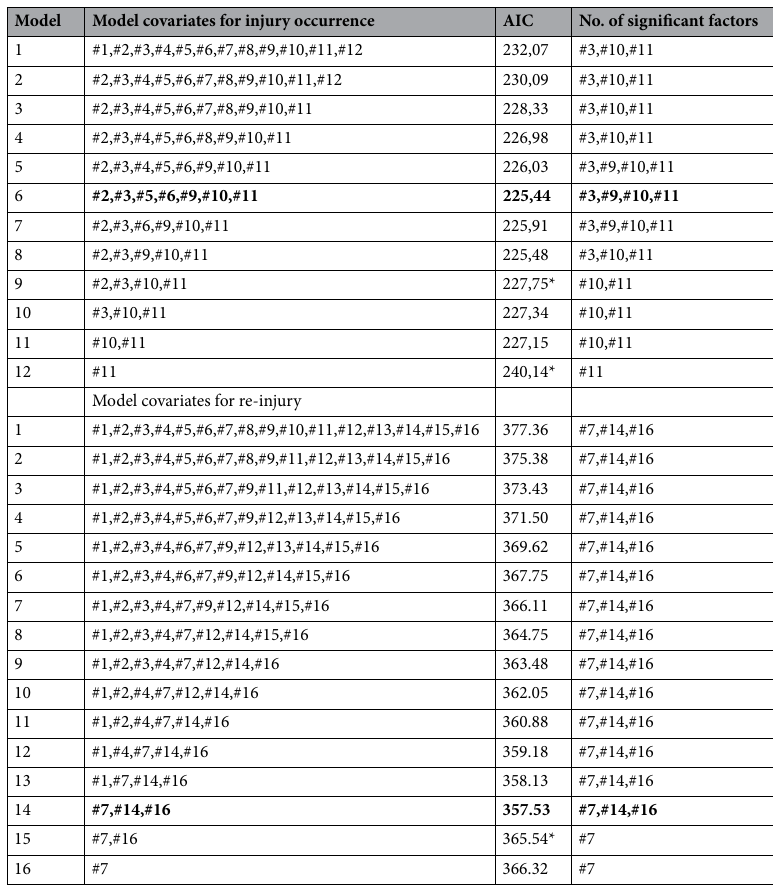
Table 2. Best models identified for injury occurrence and for re-injury depending on AIC criterion. *Model significantly different (p < 0.05) from the previous model, e.g., for injury occurrence model number 9 differs significantly from model number 8.